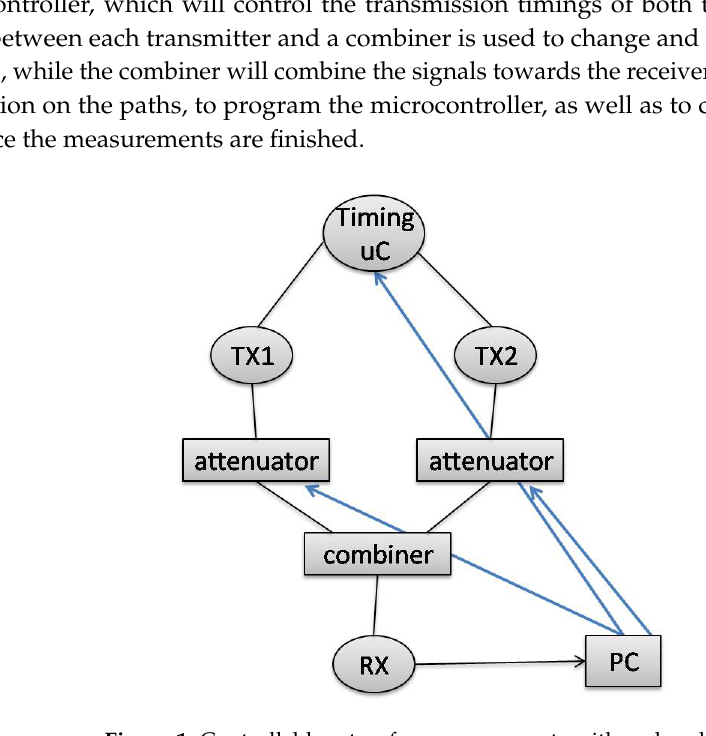
Figure 1. Controllable setup for measurements with real